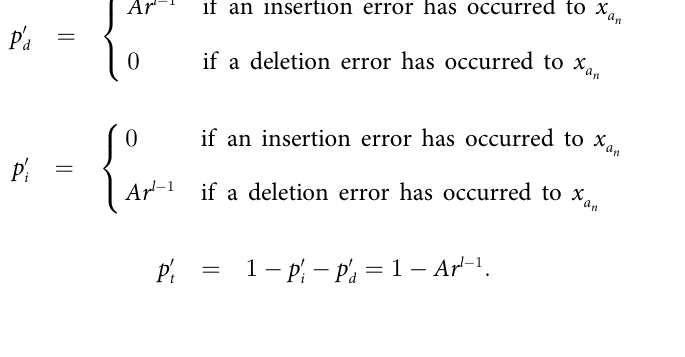
PLOS ONE | https://doi.org/10.1371/journal.pone.0270247 July 8,